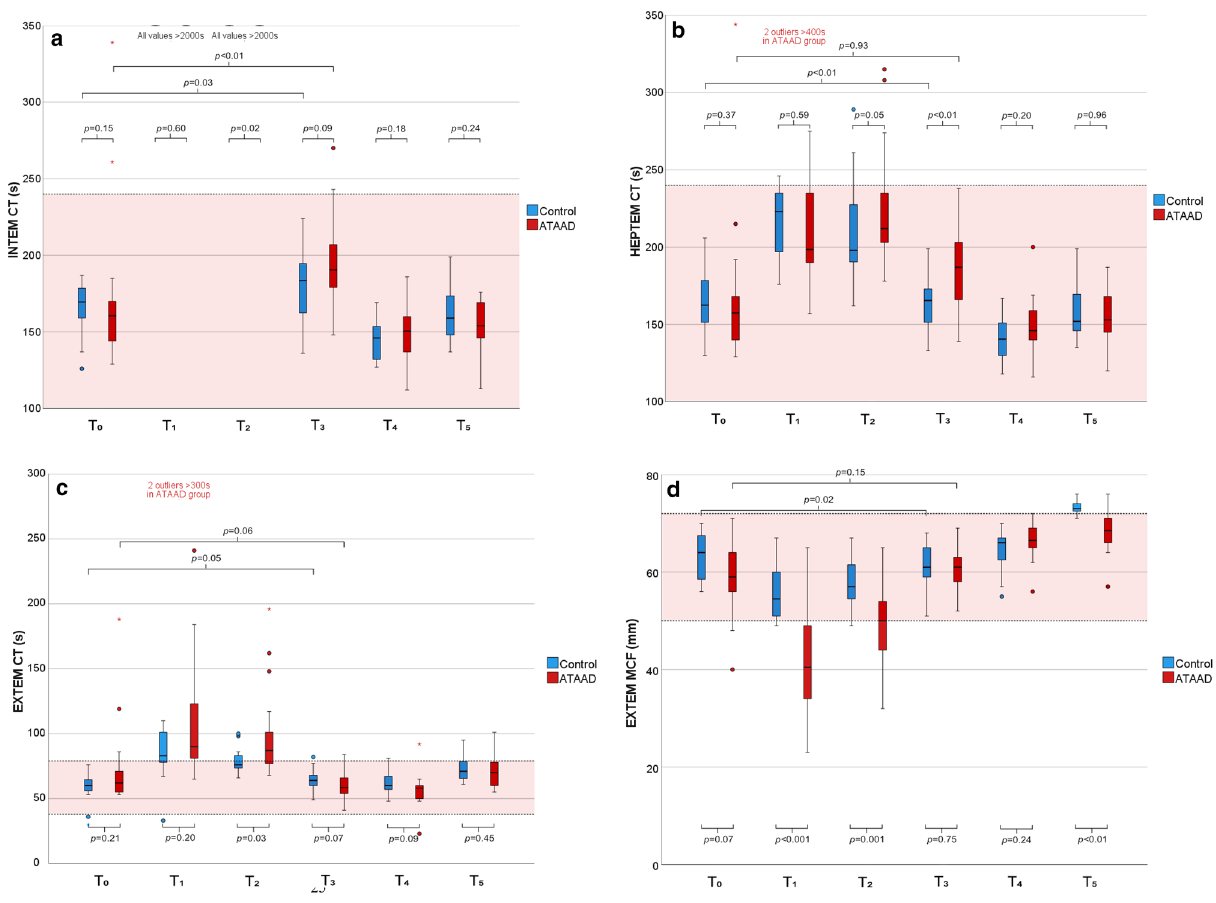
Figure 3. ROTEM analyses. ( a ) INTEM CT. ( b ) HEPTEM CT. ( c ) EXTEM CT. ( d ) EXTEM MCF. ( e ) EXTEM A10. ( f ) FIBTEM MCF. ( g ) FIBTEM